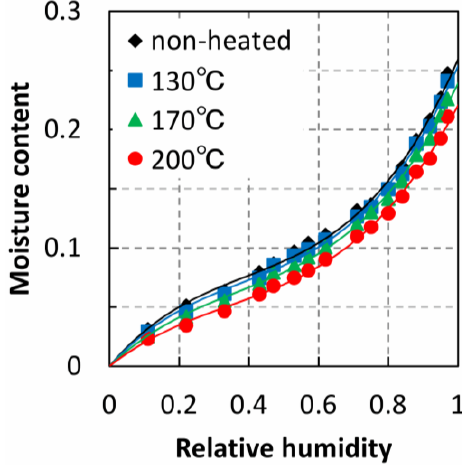
Figure 6. Moisture adsorption isotherm curves of heated specimens.